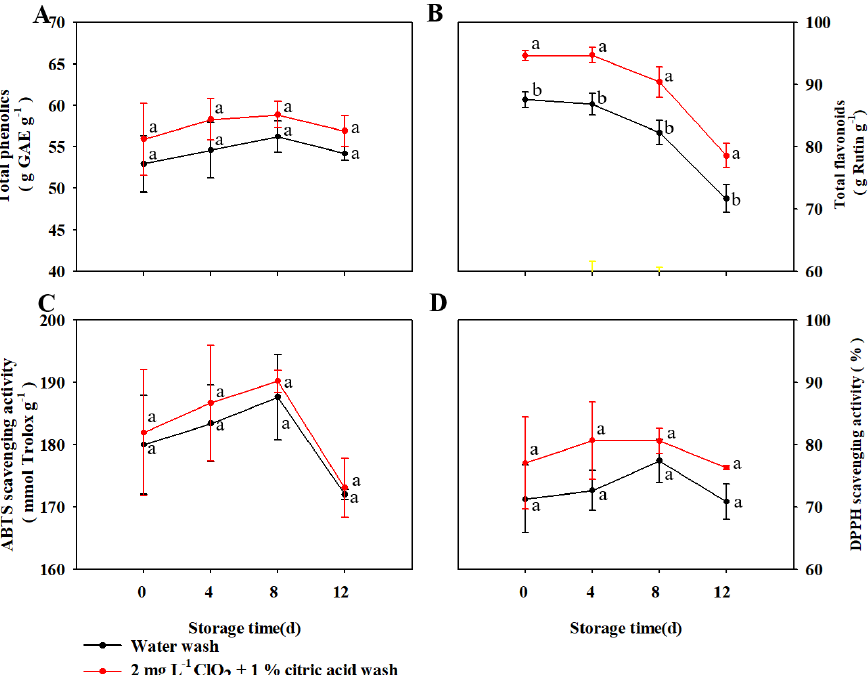
Figure 4. The changes in contents of total phenolics ( A ) and total flavonoids ( B ), and 2,2′ -azino-bis (3-ethylbenzothiazoline-6-sulfonic acid) (ABTS) ( C ) and Diphenylpicrylhydrazyl (DPPH) ( D ) radical scavenging activity of TBM packed by LDPE bags during 5 °C storage. The vertical bar represents ± standard error. Significant differences between samples (within the same time point) are indicated with different lowercase letters above the plots.